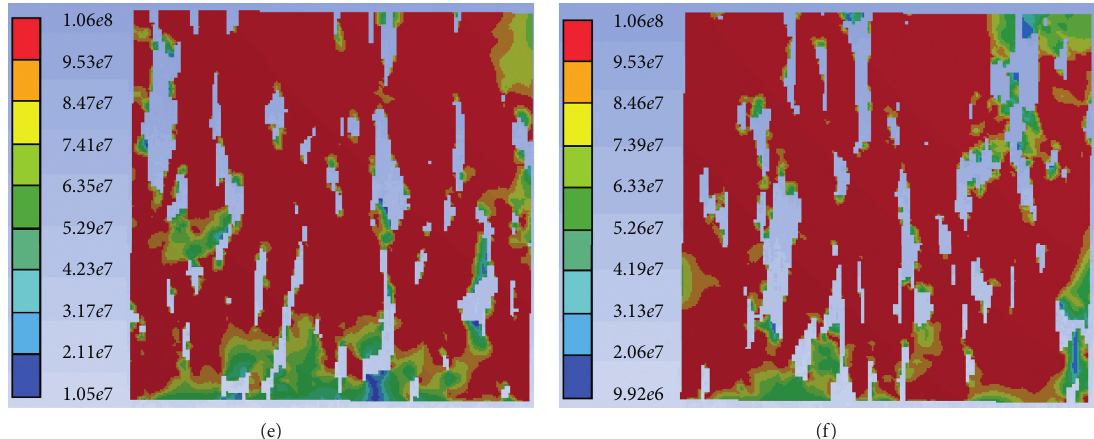
Figure 7: Cross-sections averaged von Mises stress distribution of model S2 (unit: Pa): (a) spatial location of slices at (b) y � 1mm, (c) y � 0.8mm, (d) y � 0.6 mm, (e) y � 0.4mm, and (f) y �